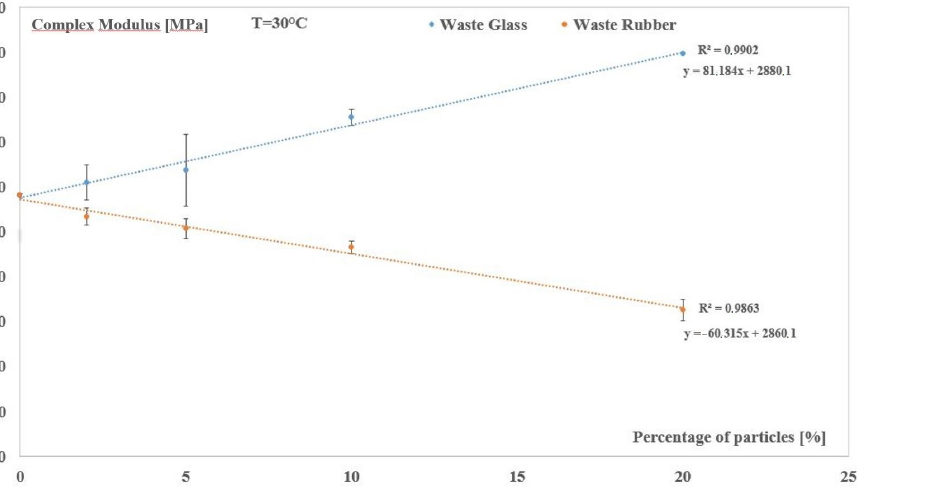
Figure 6. Complex modulus comparison between glass and rubber waste particles loaded composites at 30 ◦